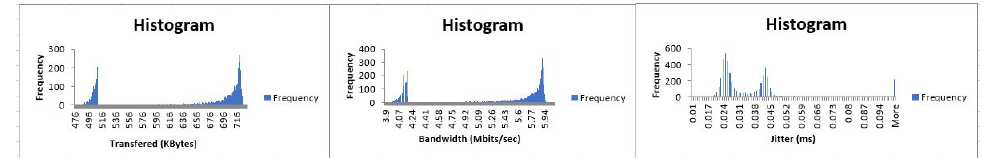
Figure 10. Node 3 with file transfer size of 16 with utilized bandwidth and jitters.